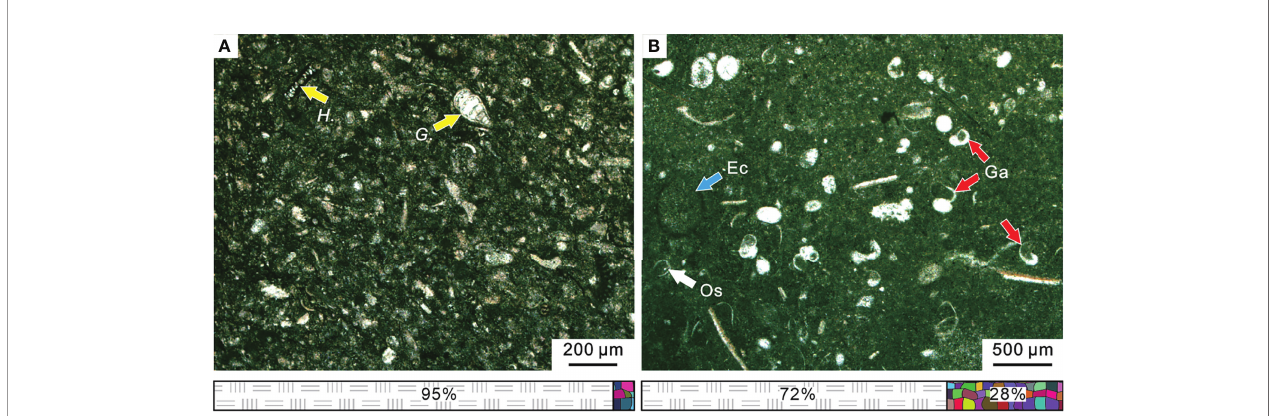
FIGURE 10 | Micropetrologic characters and fossil assemblages of micrites in the Chibi section during the PTME interval. (A) From Bed 11. (B) From Bed 15. The legend is consistent with that of Figure 4 . Ec, Echinoderm; Ga, gastropod; Os, ostracod; G ., Geinitzina sp.; H ., Hemigordius spp. The legend is consistent with that of Figure